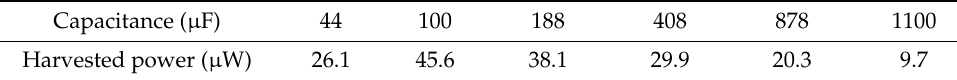
Table 4. LDT1-028K film characteristics